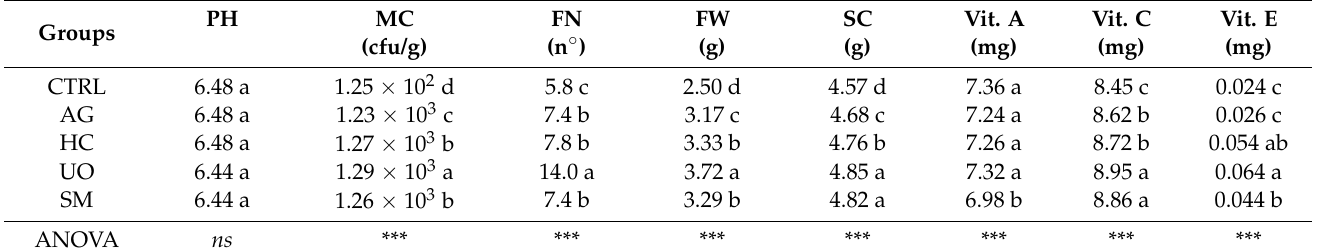
Table 2. Evaluation of microbial biomass, production, sugar and vitamin content in Mammillaria prolifera fruits .